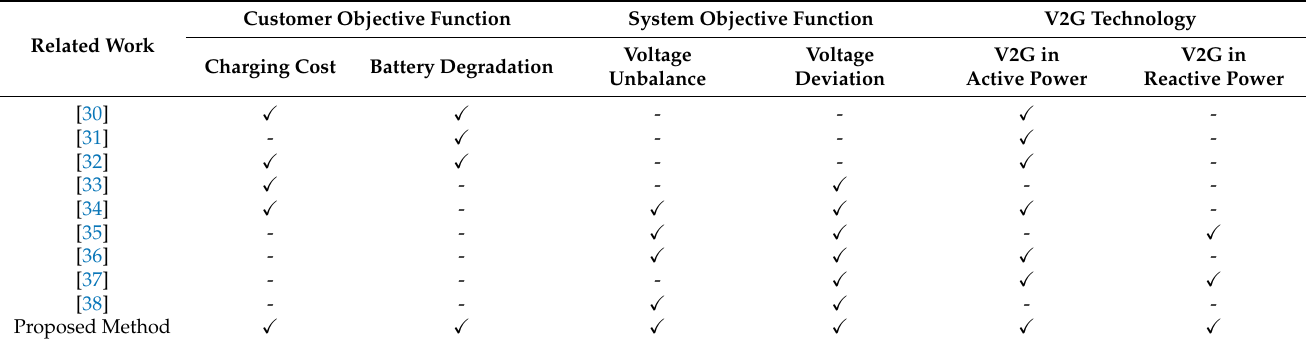
Table 1. Comparison of recent works on coordinated charging of